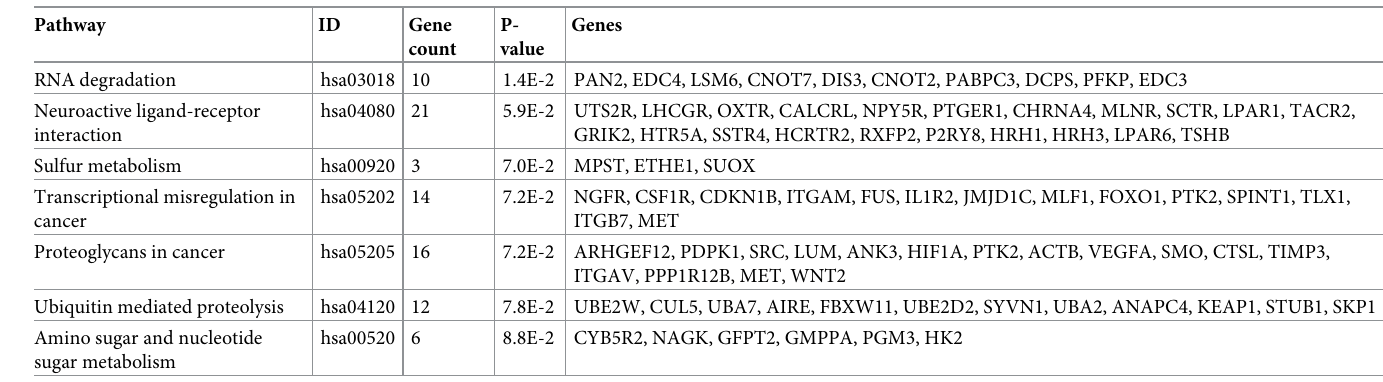
Table 2. Kyoto Encyclopedia of Genes and Genomes (KEGG) pathway analysis of genes in black module.